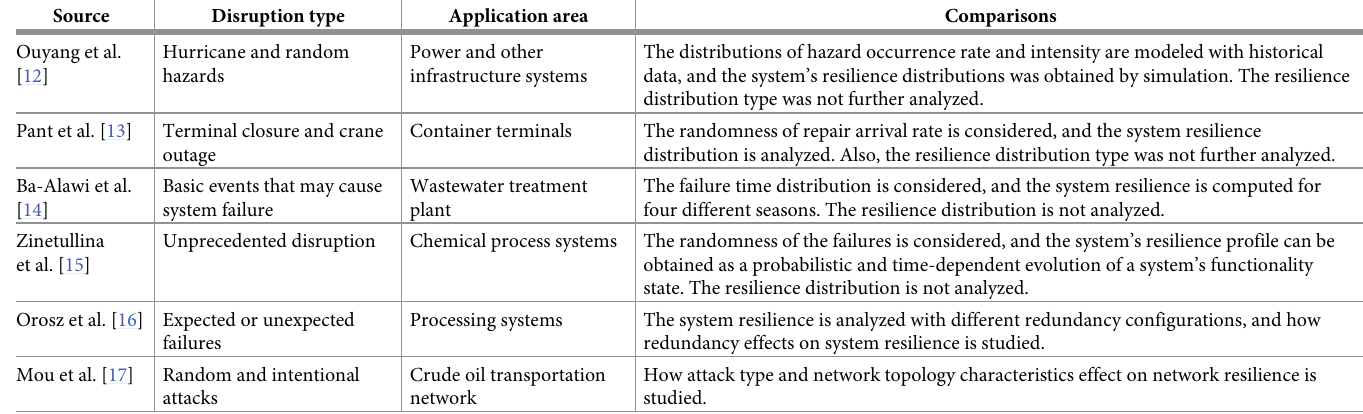
Table 1. Comparison of related works.